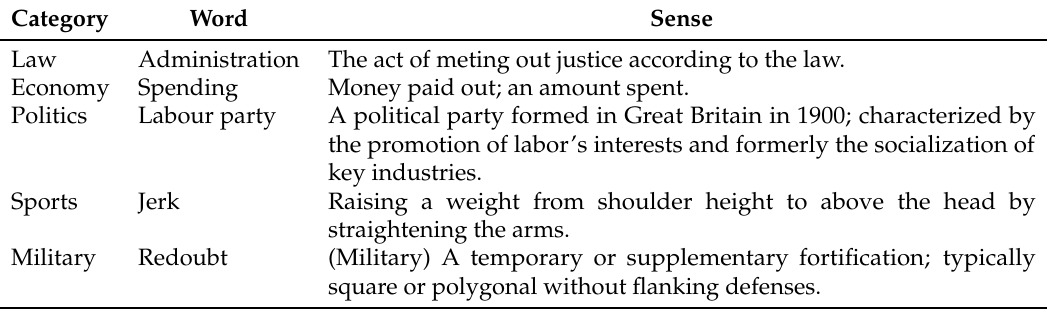
Table 3. Sense example identified by our method.